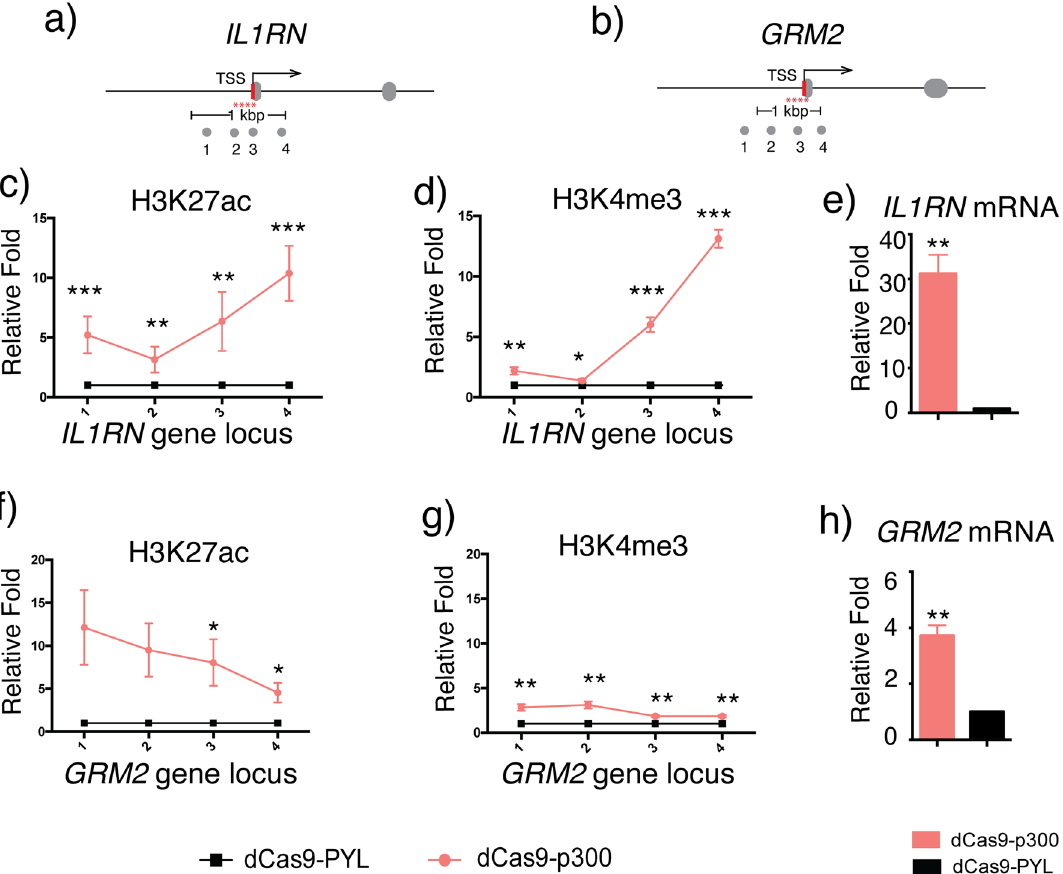
levels of ( e ) IL1RN and ( h ) GRM2 upon induced H3K27ac writing. Fold changes of H3K27ac or H3K4me3 enrichment and mRNA level changes were calculated by normalizing results to those from samples of dCas9- PYL. Error bars represent ± s.e.m. from biological replicates (n = 6 for c and d , n = 3 for e – h ). The p value less than 0.05 was marked as *, less than 0.01 as ** and less than 0.001 as